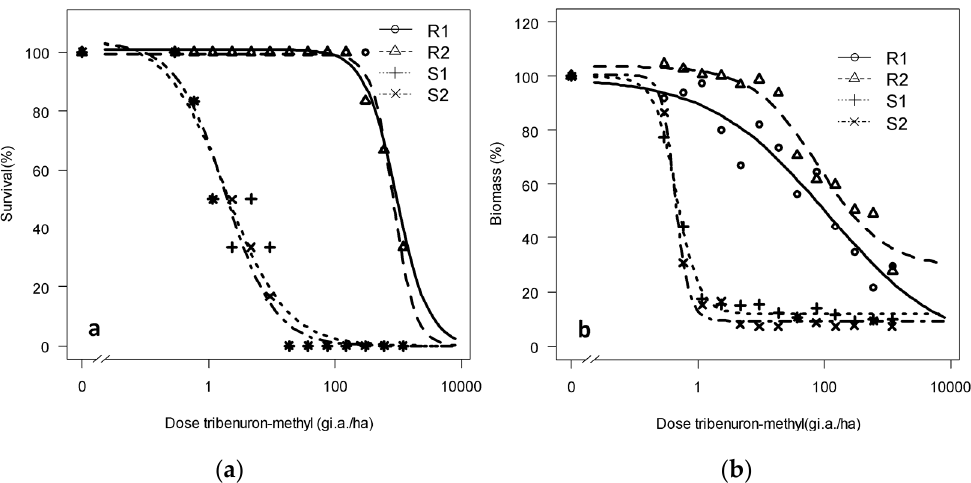
Figure 3. ( a ) Survival and ( b ) dry biomass of Rapistrum rugosum calculated based on those of the untreated control depending on the population and on the applied tribenuron-methyl dose 28 DAT.